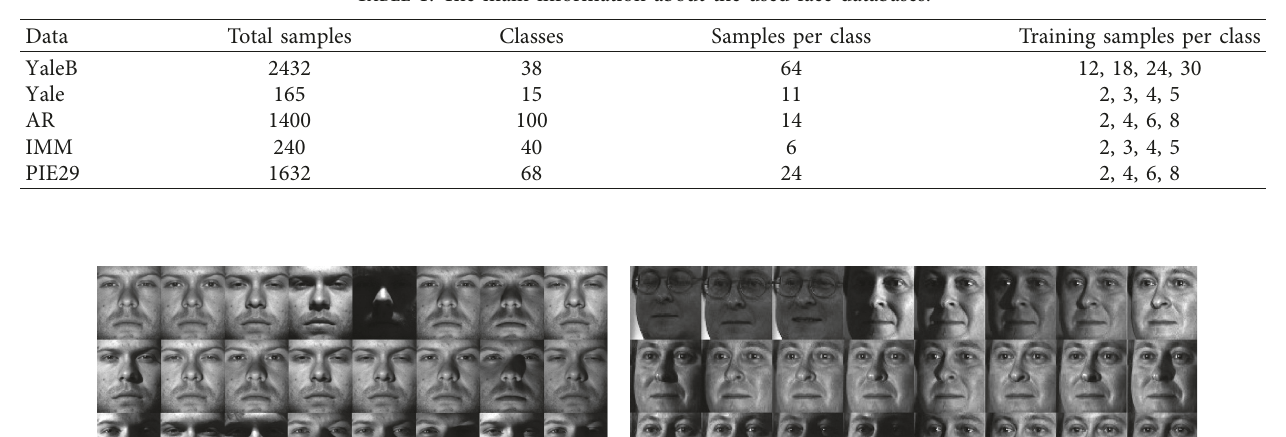
Table 1: The main information about the used face